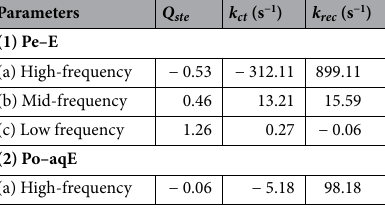
Table 1. The charge transfer efficiency (Q ste ), charge transfer ( k ct ) and recombination ( k rec ) rate calculated from IMPS curve for Pe–E and Po–aqE